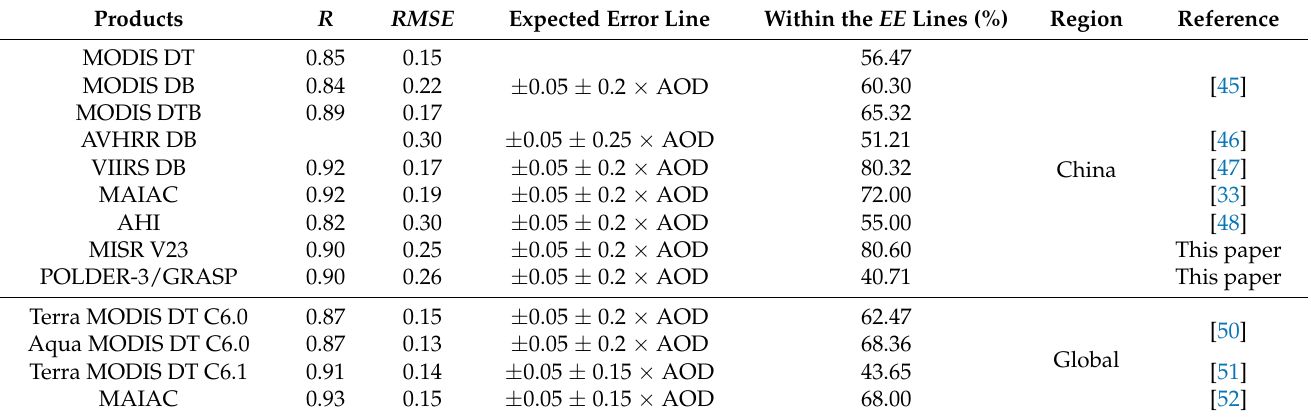
Table 6. The performance of aerosol products for